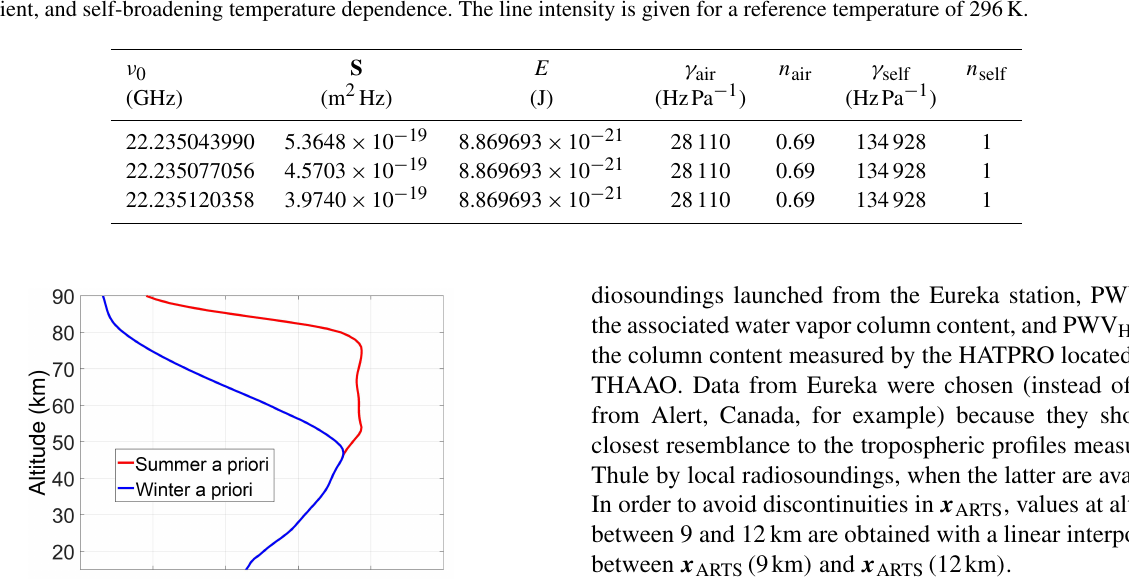
Table 3. Spectroscopic parameters (“reference” model) used for VESPA-22 retrievals. Indicated parameters, from left to right, are emission line frequency, intensity, lower state energy, pressure broadening coefficient, pressure broadening temperature dependence, self-broadening coefficient, and self-broadening temperature dependence. The line intensity is given for a reference temperature of 296K.